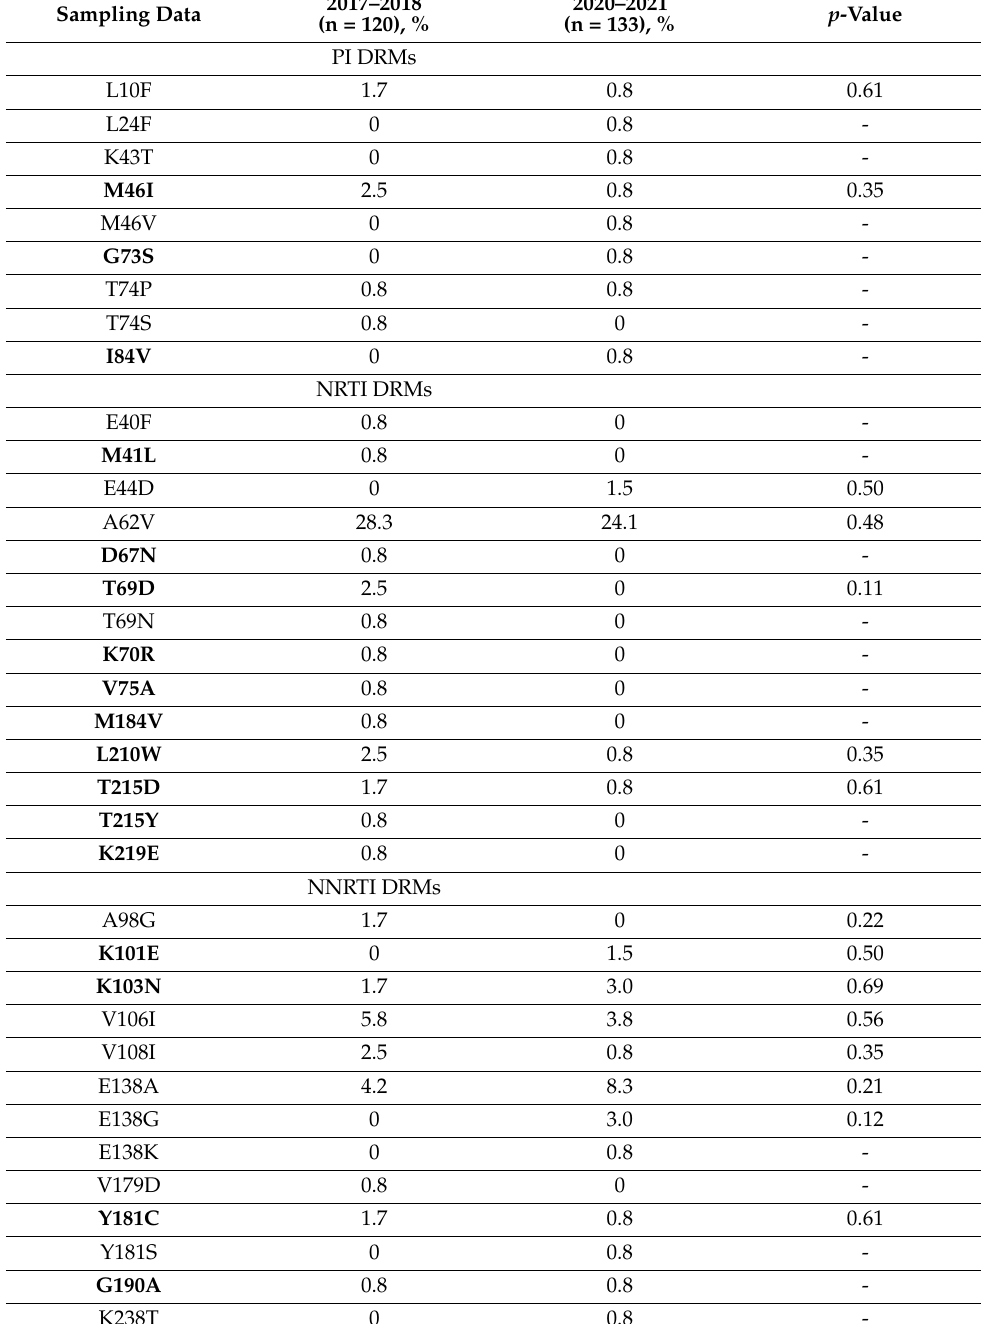
Table 2. Prevalence of DRMs in Armenia in 2017–2018 and 2020–2021. Sampling